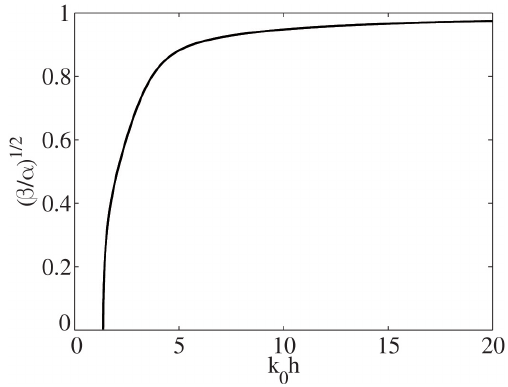
Fig. 1. Effect of finite water depth on the